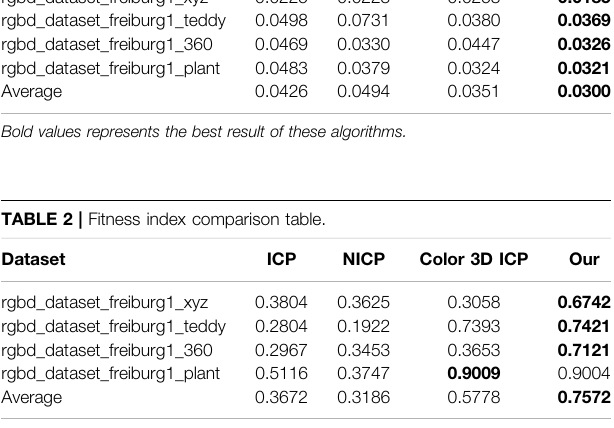
Table 2 that fi tness is signi fi cantly improved compared with the aforementioned algorithm, indicating that the number of feature the original point cloud.